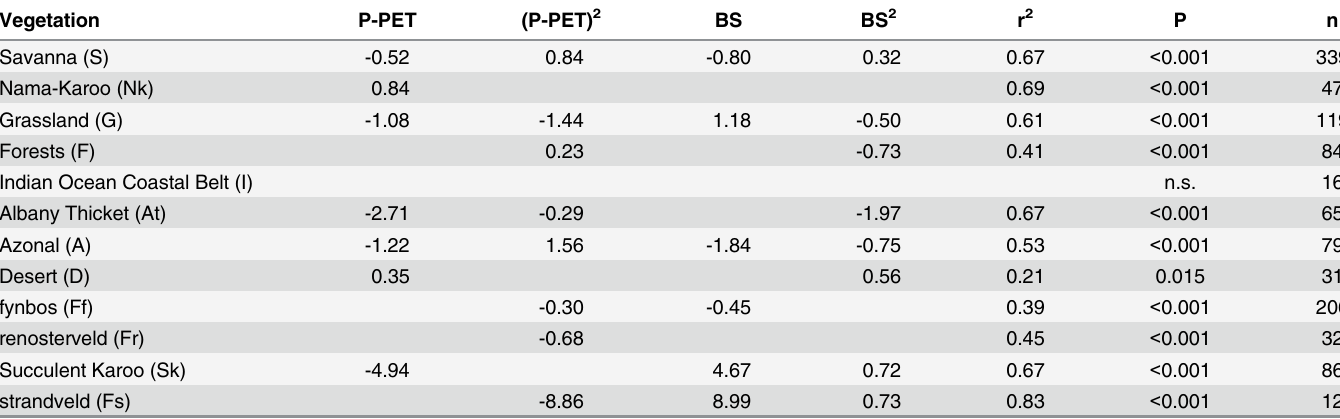
Table 3. Comparison of the multiple regression standardized coefficients for average annual NDVI regressed on water availability (P-PET) and base saturation (BS) for the vegetation types of South Africa, as defined by Mucina and Rutherford (2006), but with the Fynbos separated into strandveld, renosterveld and fynbos.